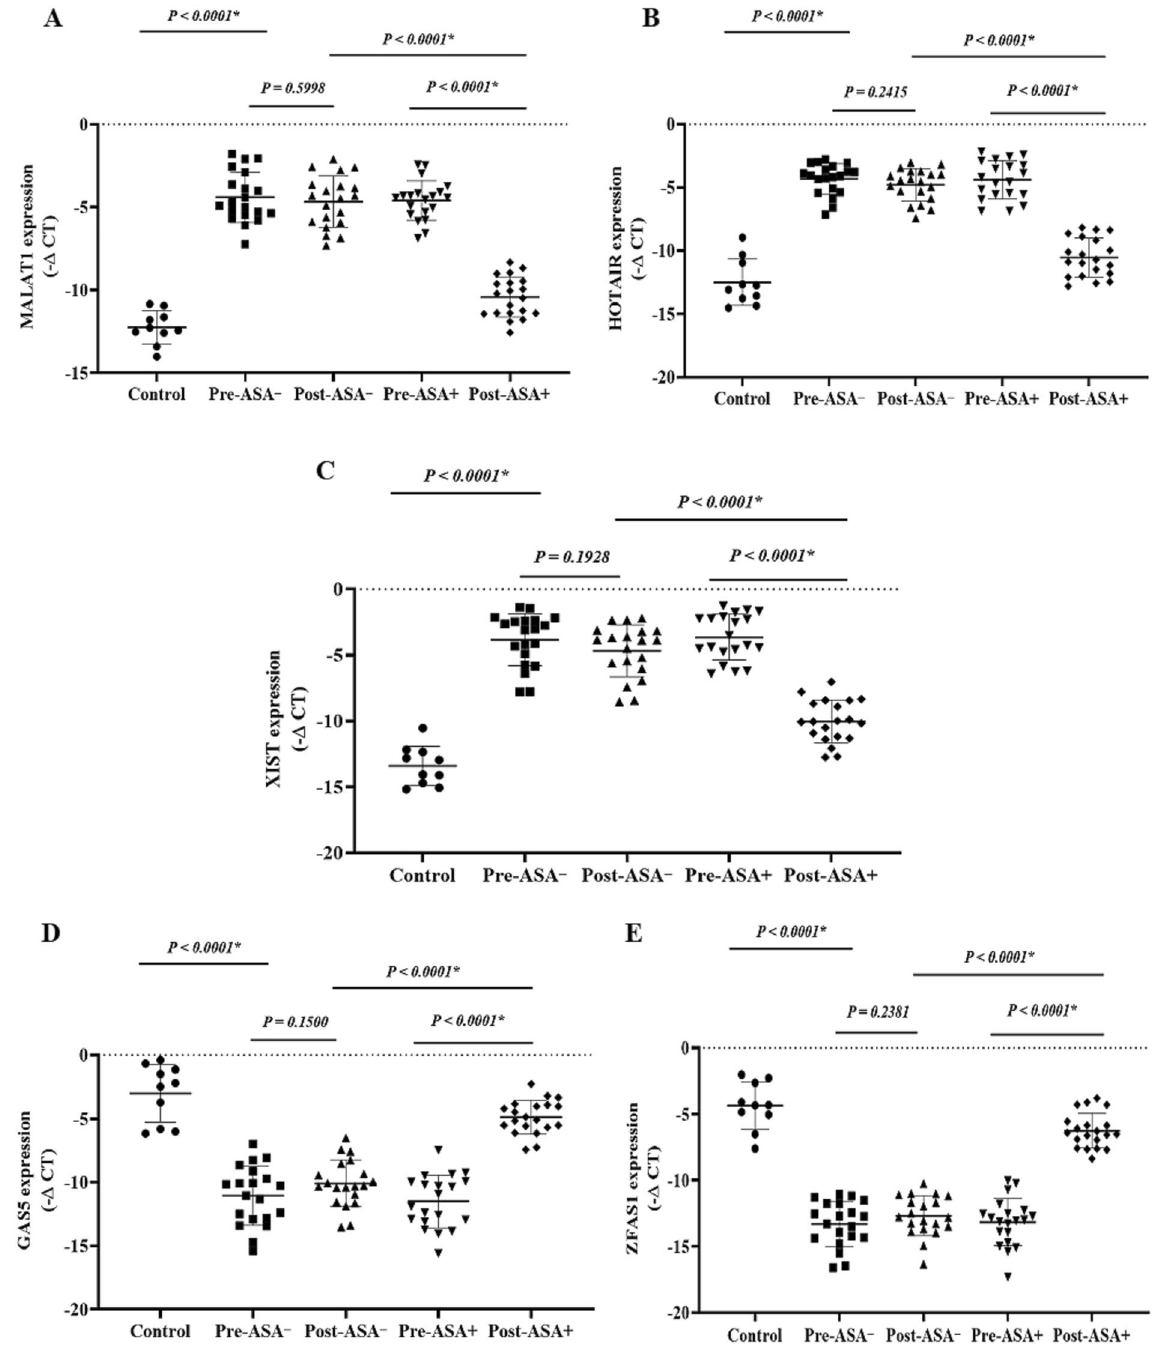
Figure 6 . The relative expression of the candidate lncRNAs in the breast cancer patients. The relative expression levels of the lncRNAs were normalized by a reference RNA. The oncolncRNAs included: ( A ) MALAT1, ( B ) HOTAIR, and ( C ) XIST. Tumor suppressor lncRNAs included: ( D ) GAS5 and ( E ) ZFAS1. ASA−: Non-aspirin group, ASA+: Aspirin group. The expression levels of the lncRNAs were calculated using the –ΔCT